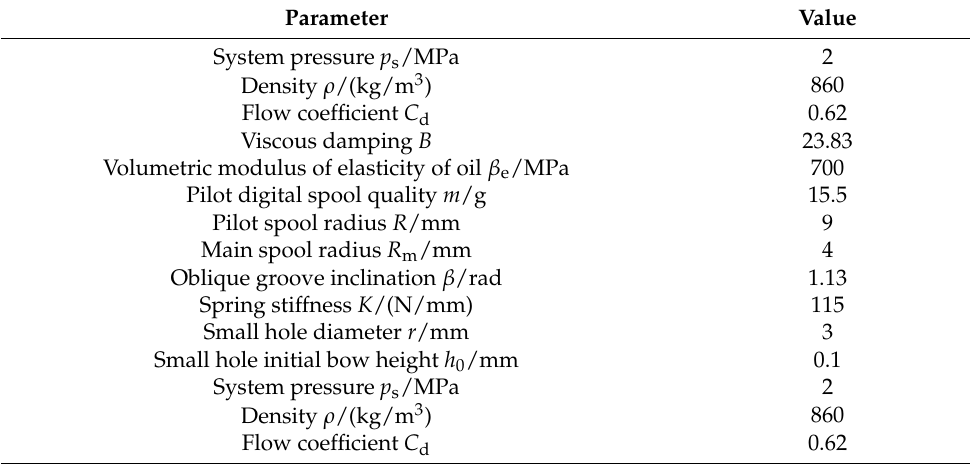
Table 1. The 2D digital buffer valve simulation parameters.